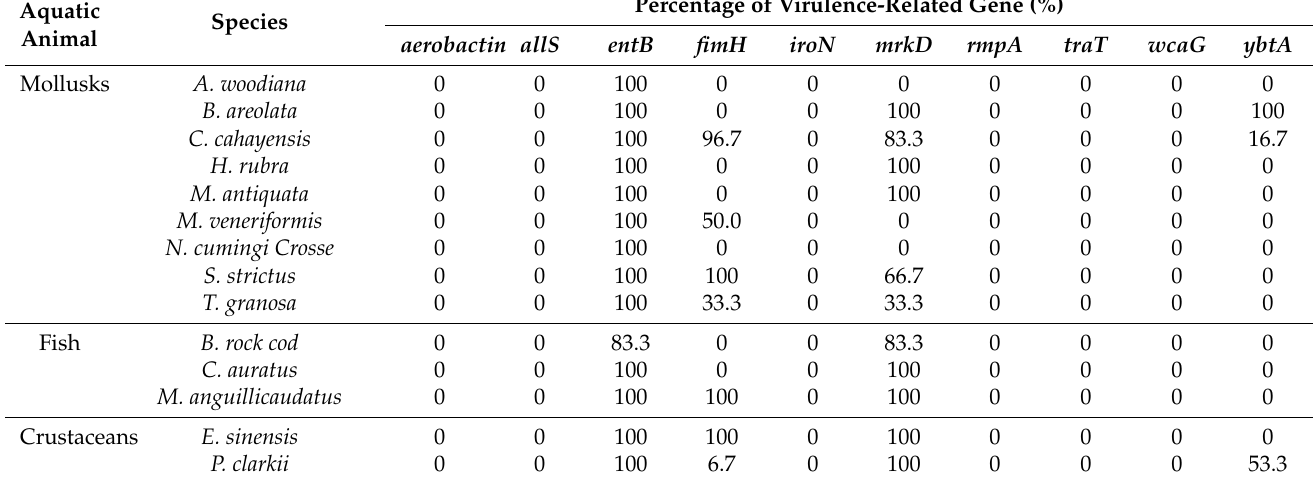
Table 1. The virulence-related genes in the 94 K. pneumoniae strains isolated from the 14 species of aquatic